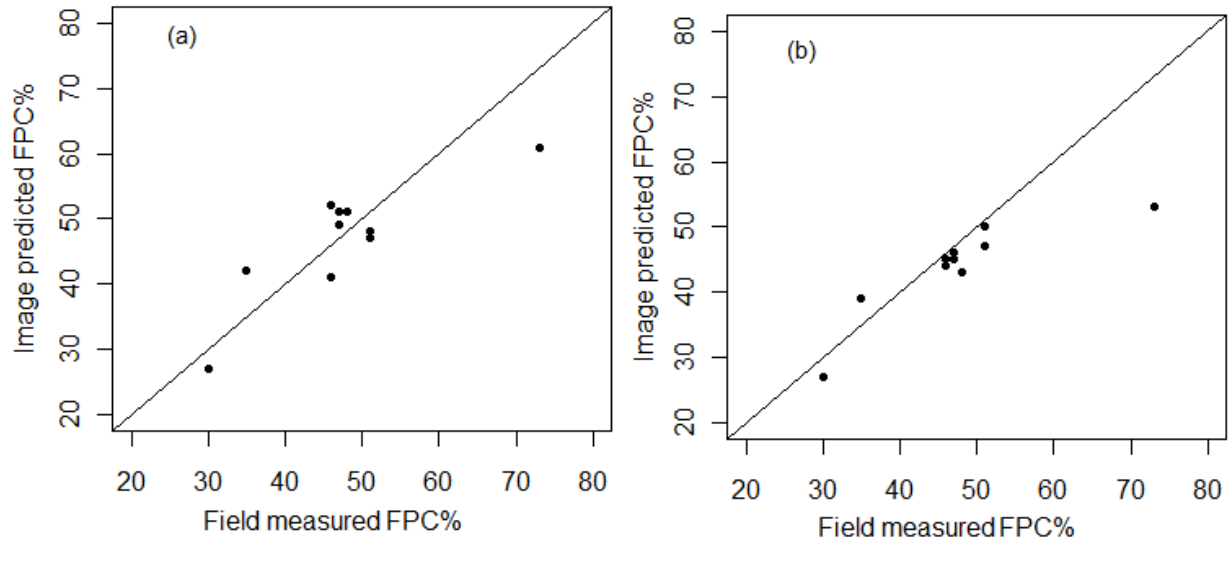
Figure 6. Comparison of predicted Landsat TM image derived foliage projective cover (FPC) of: ( a ) 2005/07/08; and ( b ) 2005/07/24 with field measured FPC from